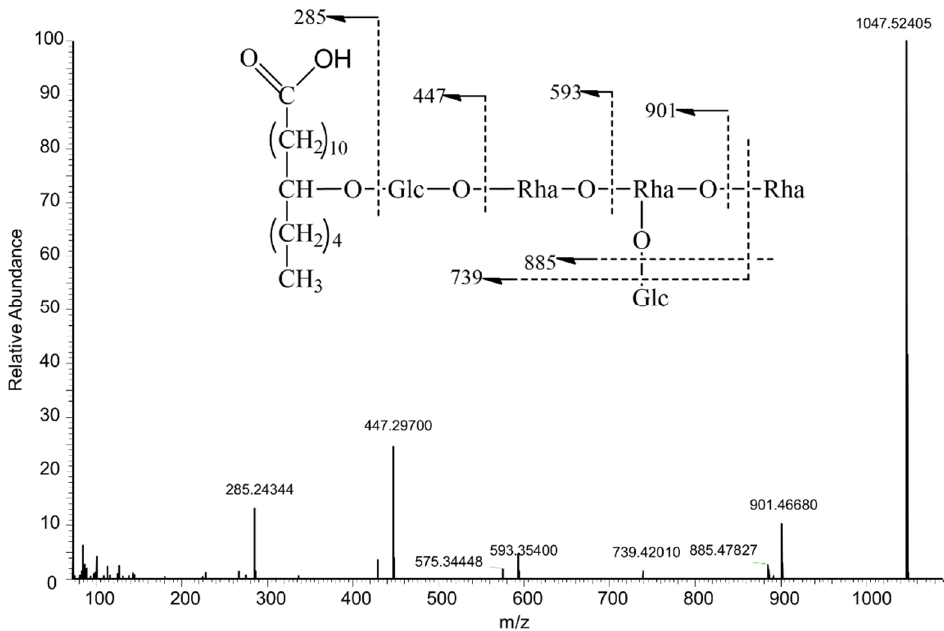
Figure 1. Proposed fragmentation pathway of Turpethic acids C .